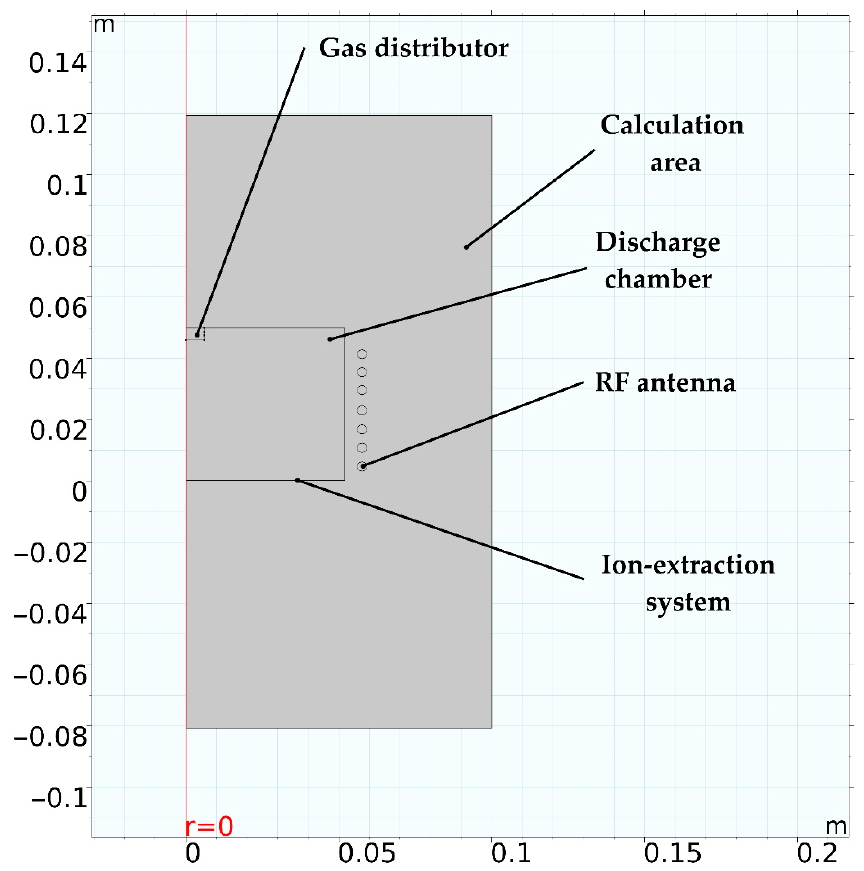
Figure 2. Calculation domain in the COMSOL Multiphysics software package [17].